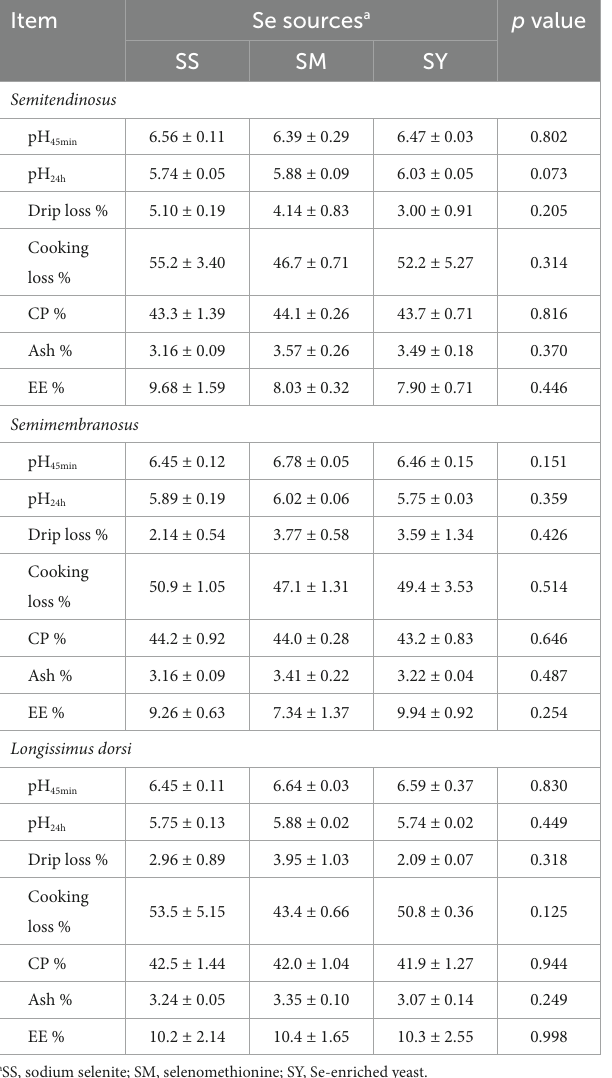
TABLE 3 Effects of different Se sources on the meat quality and composition of beef cattle.